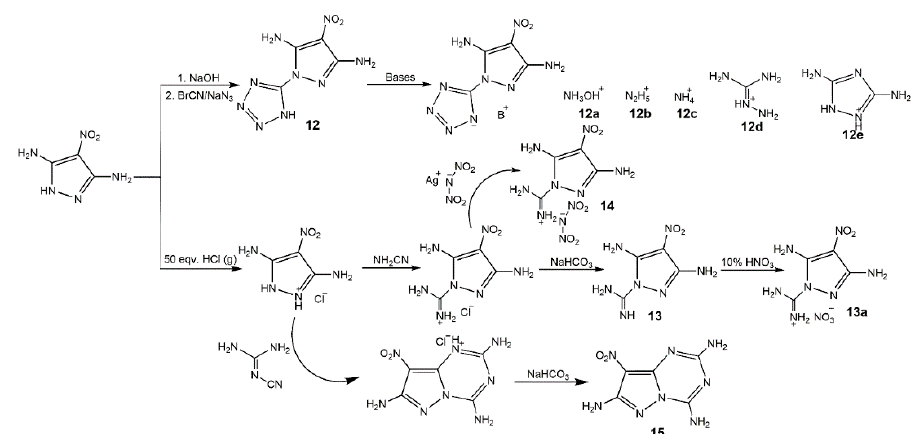
Figure 6. Synthesis of mononitropyrazole derivatives 8 – 11 .